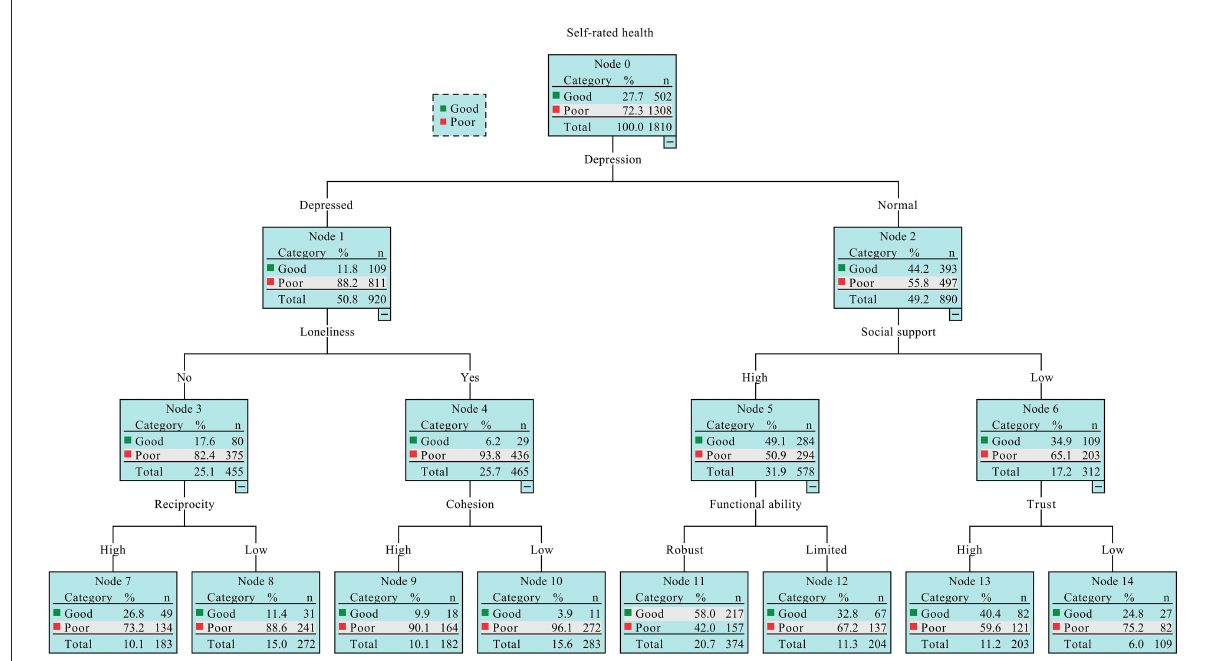
FIGURE1 The classification and regression tree (CART) model output of the combinations of social capital factors and